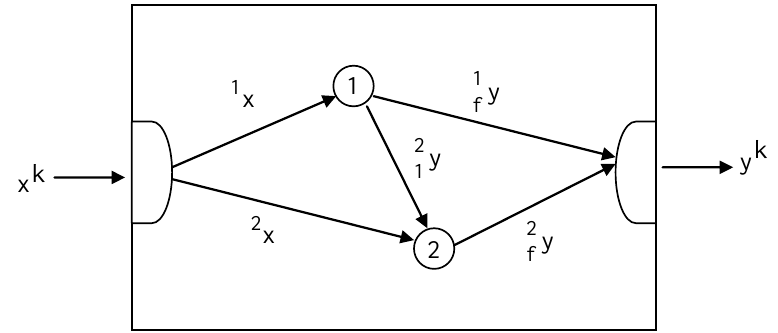
Figure 2. Network production system with intermediate products [33].